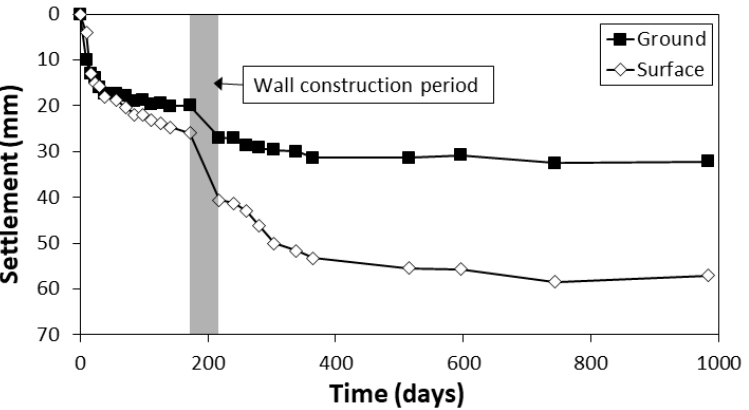
Figure 11. Ground and surface settlements.